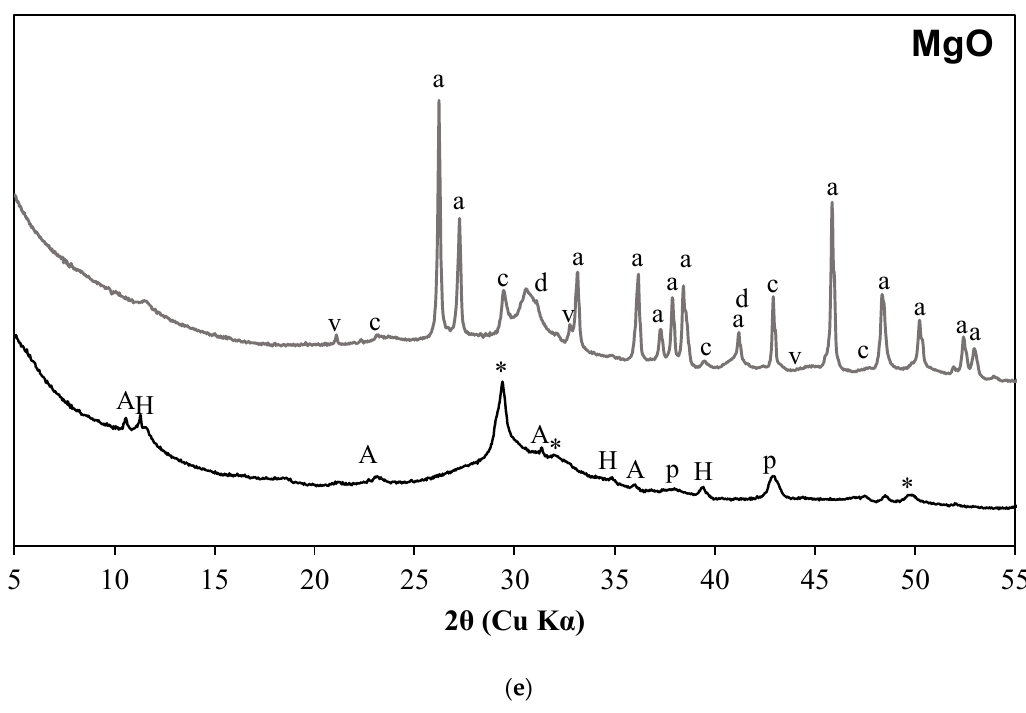
Figure 1. Diffractograms of activated slag before and after being exposed to sCO 2 . ( a ) NaOH ( b ) Na 2 SiO 3 ( c ) Na 2 SO 4 ( d ) CaO ( e ) MgO. Samples exposed to sCO 2 are stacked on top and are represented with a grey color. (*—C-S-H, A—AFm Phases, E—ettringite, G—gypsum, H—hydrotalcite,